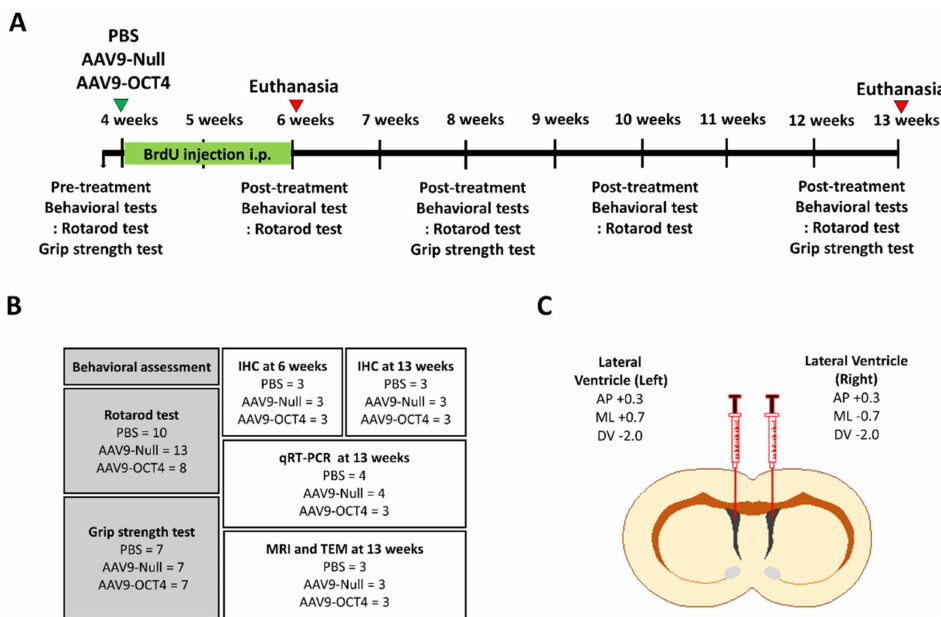
Figure 1. Experimental scheme for in vivo expression of OCT4 in HD mice. ( A ) The schedule of OCT4 treatment and behavioral tests (rotarod and grip strength tests) in the timeline are presented. ( B ) A total of thirty-one R6/2 mice were randomly assigned to PBS (N= 10), AAV9-Null (N = 13) and AAV9- OCT4 (N = 8) for behavioral assessment to investigate behavioral outcomes. Among the subjects, nine mice were recruited for the IHC, MRI and TEM imaging at 13 weeks of age (N = 3 per group). A total of eleven mice were also recruited to evaluate OPC related genes using a qRT-PCR (PBS (N = 4), AAV9-Null (N = 4), AAV9-OCT4 (N = 3). ( C ) Both side lateral ventricle injection using stereotaxic surgery performed at 4 weeks of